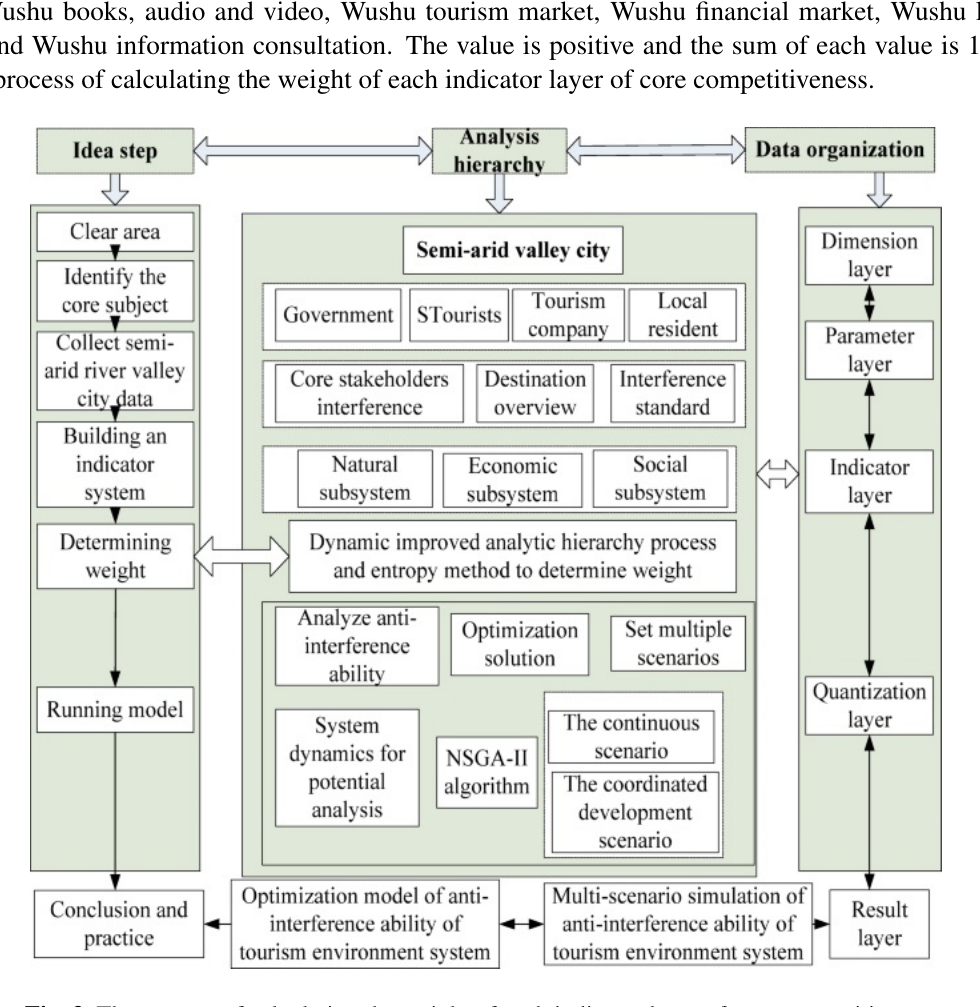
Fig. 3 The process of calculating the weight of each indicator layer of core